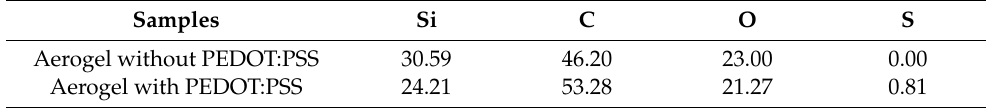
Table 1. The element content comparison of aerogel without PEDOT:PSS and aerogel with PEDOT:PSS. Samples Si C O Aerogel without